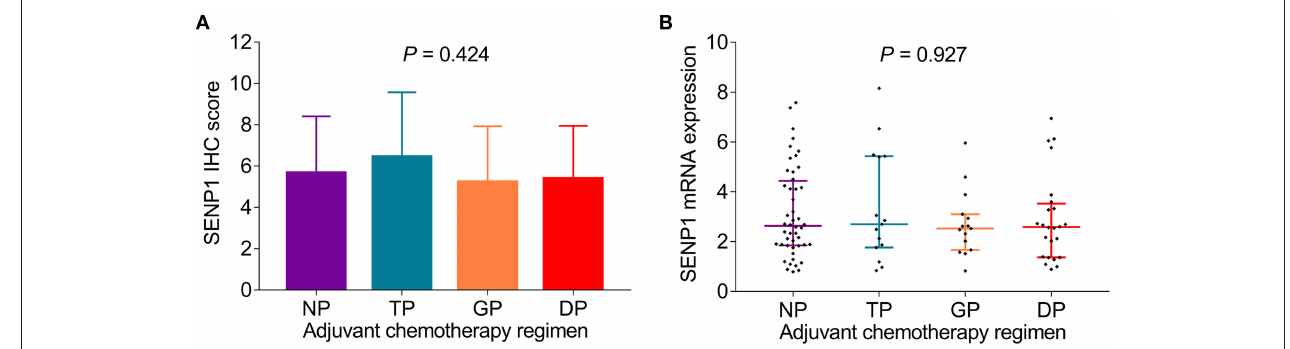
FIGURE 2 | Comparison of SENP1 expression among patients with surgical NSCLC receiving different adjuvant chemotherapy regimens. Comparison of SENP1 IHC score (A) and SENP1 mRNA expression (B) among patients with NSCLC who received NP, TP, GP, and DP. SENP1, small ubiquitin-like modifier (SUMO)-specific protease 1; IHC, immunohistochemistry; NP, vinorelbine + cisplatin; TP, taxol + cisplatin or carboplatin; GP, gemcitabine + cisplatin or carboplatin; DP, docetaxel + cisplatin or carboplatin; NSCLC, non-small cell lung cancer.